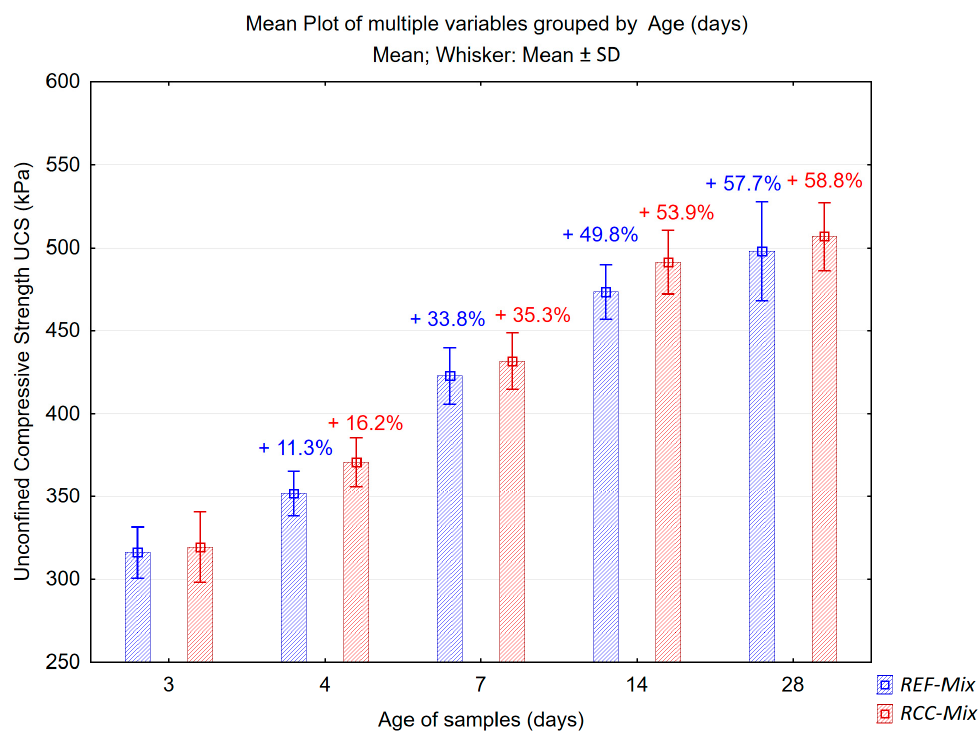
Figure 13. Results of the unconfined compressive strength tests on the samples from the REF-Mix and RCC-Mix mixtures for the age of samples (age); error bars show standard deviations; increase of unconfined compressive strength shown as a percentage.